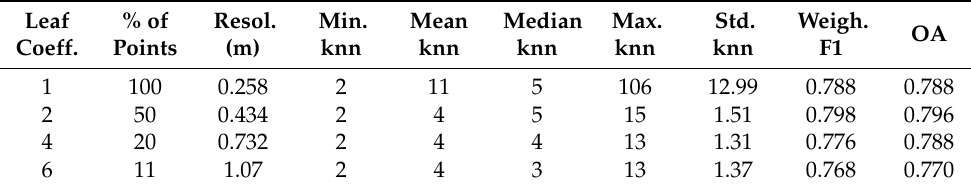
Table 3. Density analysis on the ISPRS Vaihingen